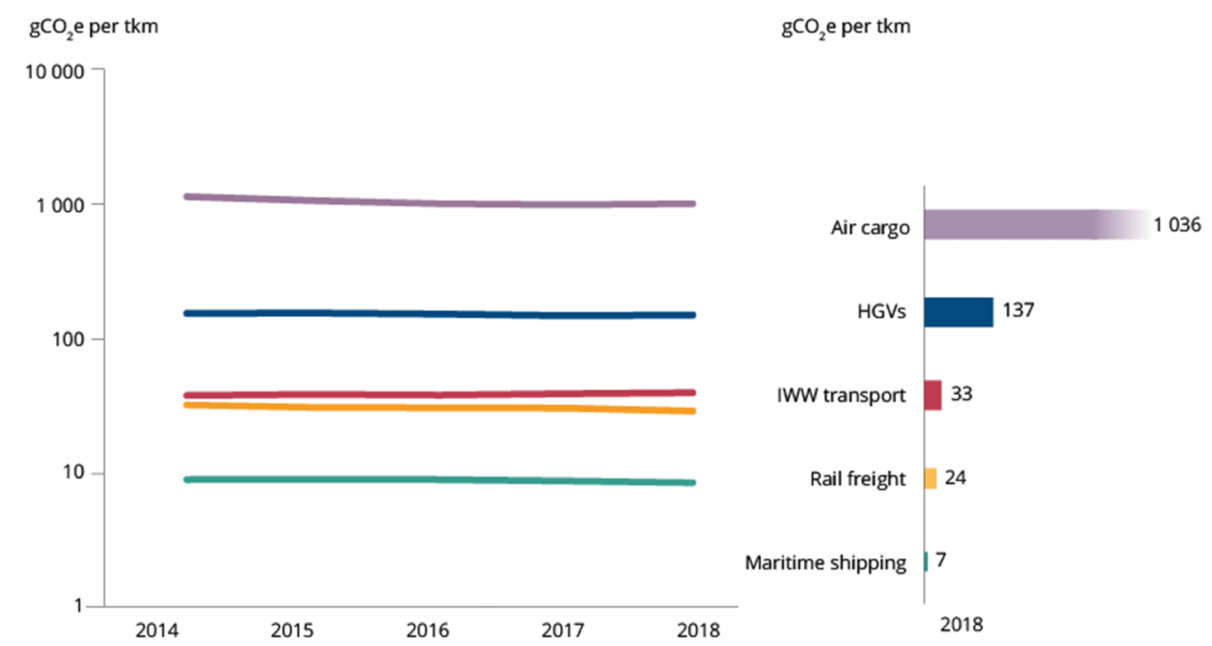
Figure 7. Average GHG emissions by motorised mode of freight transport, EU-27, 2014–2018. Source: Fraunhofer ISI and CE Delft, 2020 https://www.eea.europa.eu/publications/rail-and-waterborne- transport, accessed on 30 January